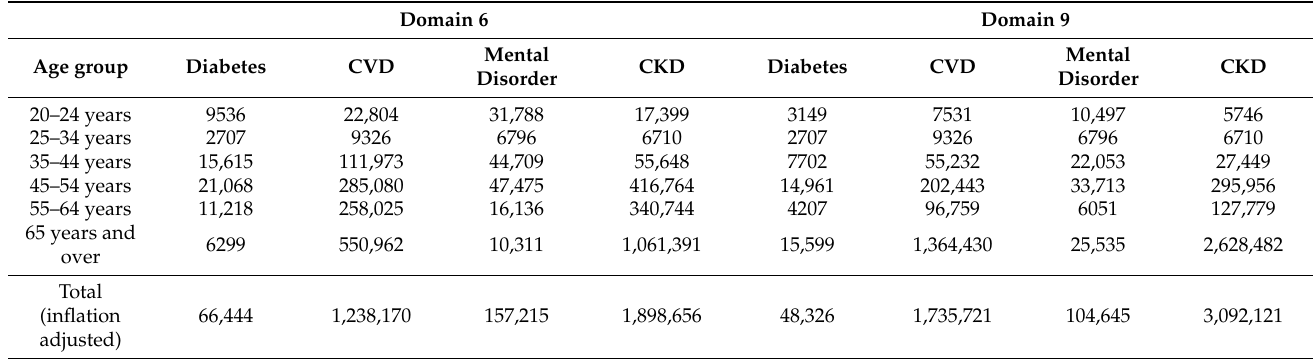
Table A15. Extra costs incurred due to LHL for people with different chronic conditions—Method